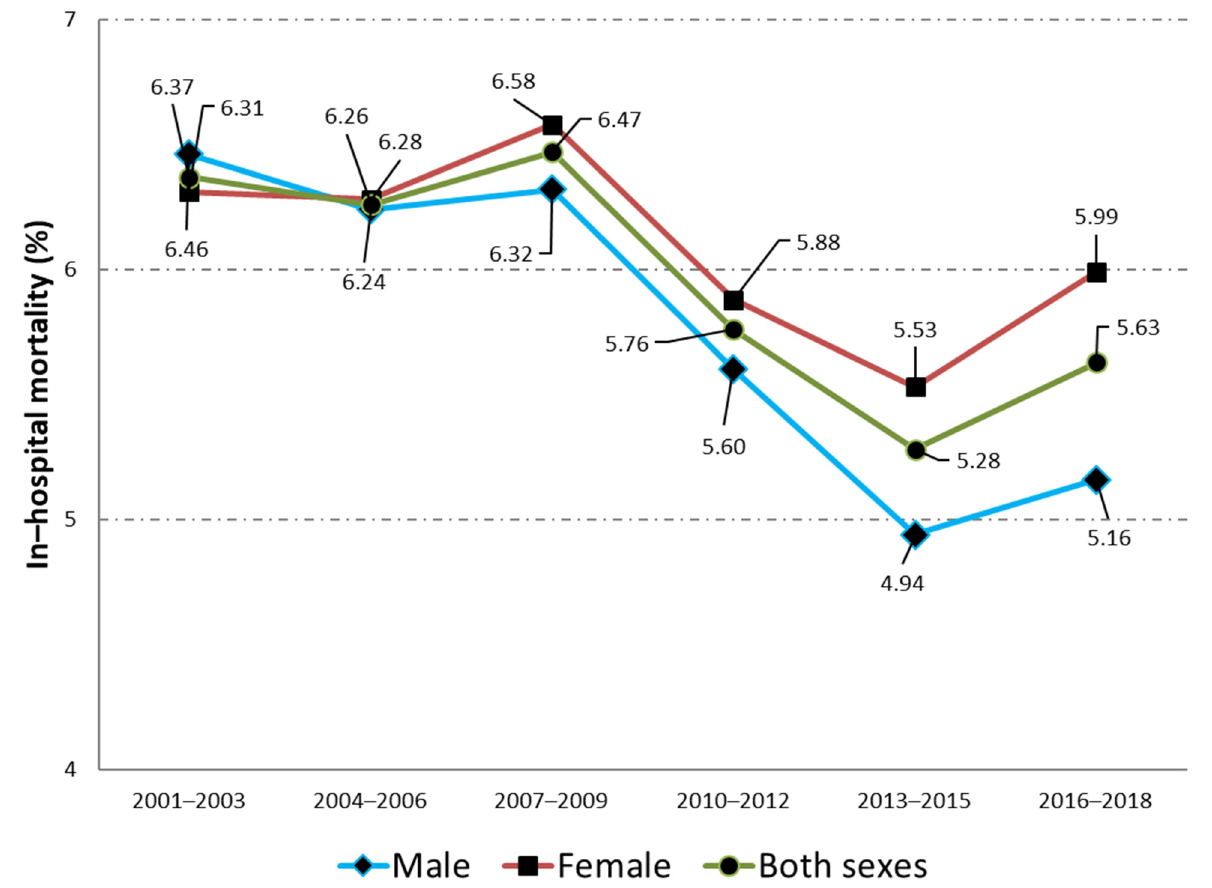
Figure 1. Time trend, from 2001–2003 to 201620–18, in the in-hospital mortality for men and women admitted to the hospital with a principal diagnosis of urinary tract infection.